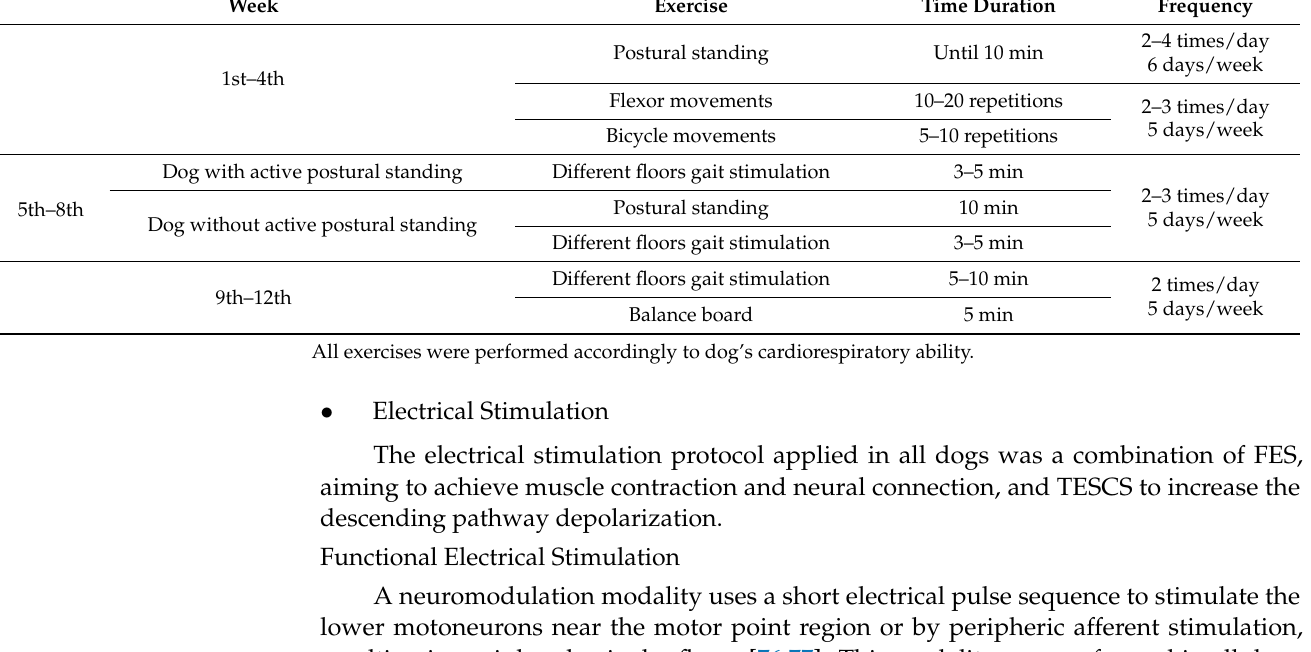
Table 4. Kinesiotherapy exercise training.